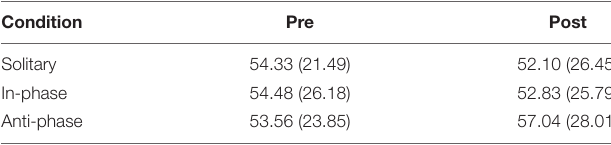
TABLE 1 | Means and standard deviations of pain threshold by